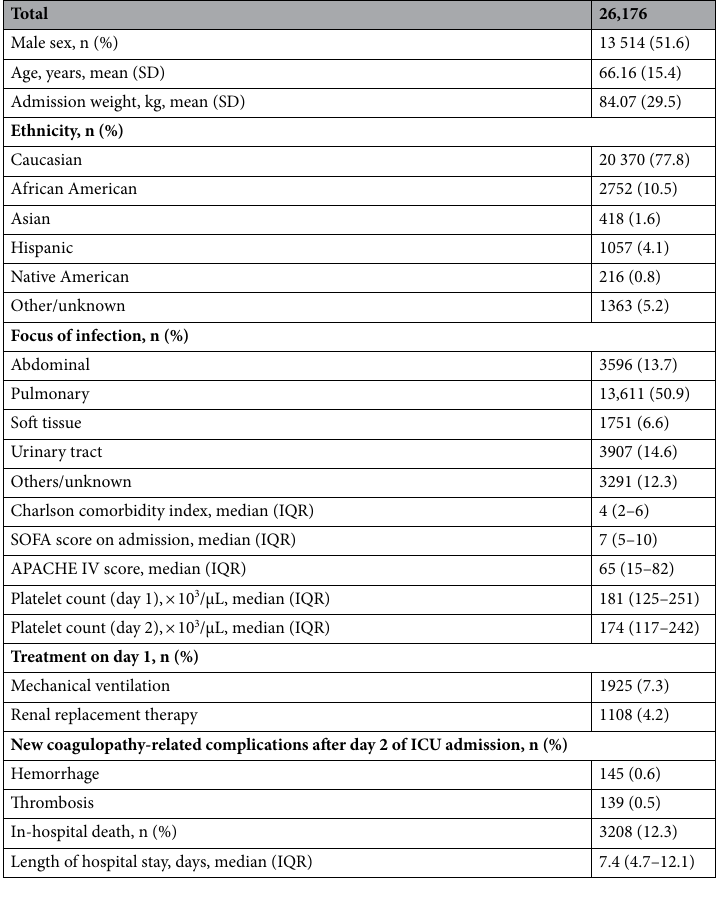
Table 1. Baseline characteristics. SD standard deviation; IQR interquartile range; SOFA sequential organ failure assessment; APACHE acute physiology and chronic health evaluation.